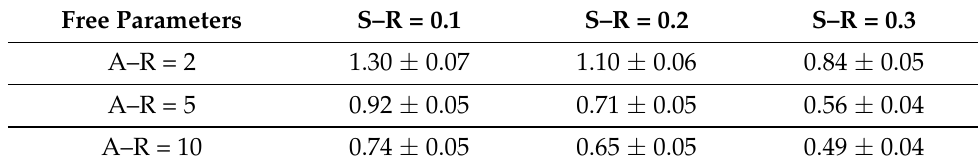
Figure 6. Representation of sequences with multiple mainshocks in 100,000 years simulated catalog, with M w ≥ 5.0. Colored lines show multiple mainshocks recognized by algorithm described in text, with colors indicating respective number of earthquakes for each of them (see histogram in log scale in the inset). Table 3. Average number of multiplets in 100,000 years simulated catalogs in groups of 370 years.